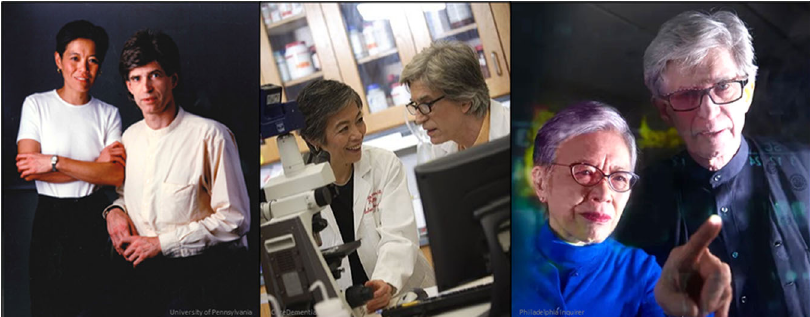
Fig. 1 John Trojanowski and Virginia Lee through the years. “ John Trojanowski was my life partner and scienti fi c partner and I had the privilege of spending the last 45 years working with him on neurodegenerative diseases. I would not have succeeded in science if it was not for his enthusiasm, his encouragement, his passion in science, and his insistence that together we can get the job done! ” — Virginia